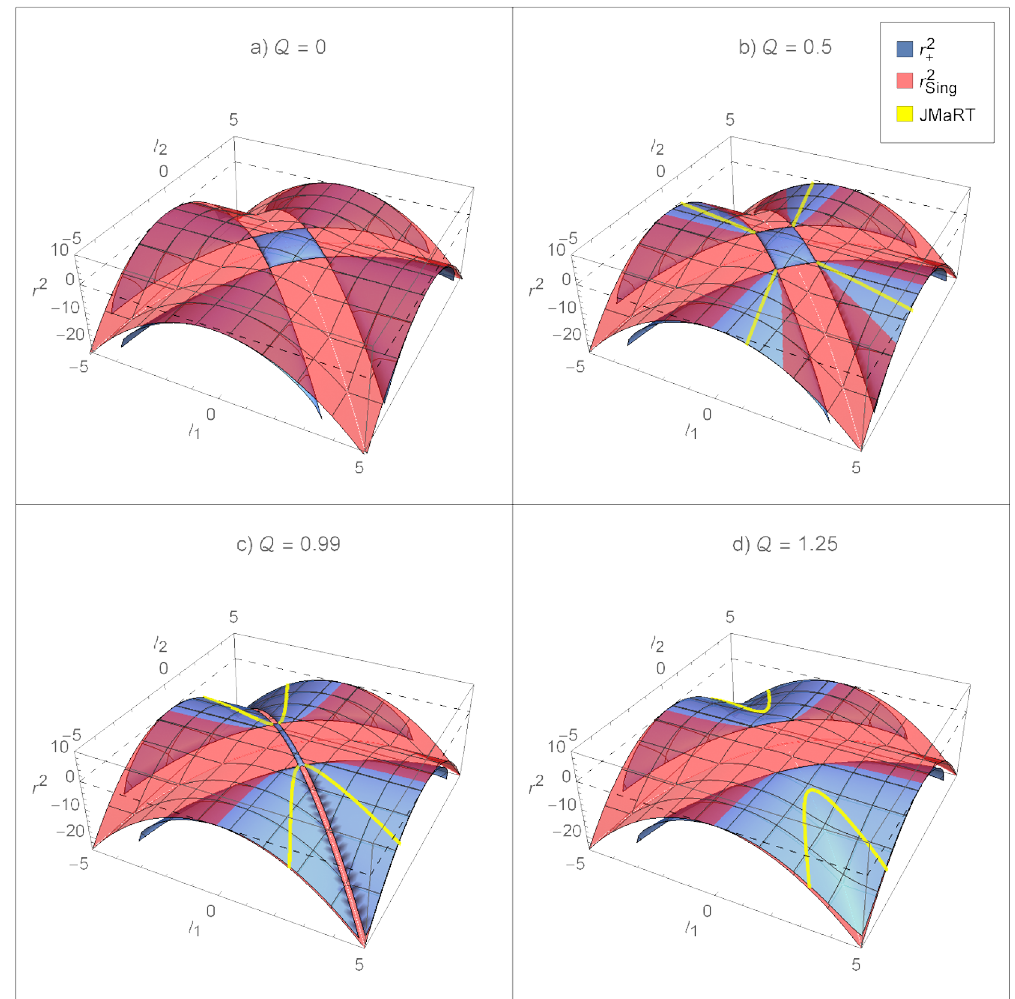
Figure 1. Moduli space of 5d solutions: BH’s (black), regular solutions (yellow), naked singularities (red) and over-rotating geometries (blue). The mass has been set to M = 1 , while the charge has been set to Q = 0 , 0 . 5 , 0 . 99 , 1 . 5 in pictures a) to d) respectively. BH’s where the singularity is hidden behind an event horizon. They exist for Q ≤ M .